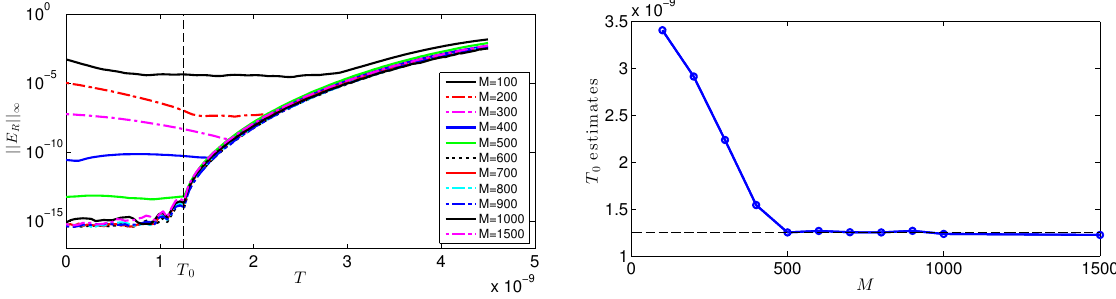
|| in the transmission line example as M varies. R ∞ = 1 . 25 ns. Right panel: estimation of 0 = 1 . 25 ns. 0